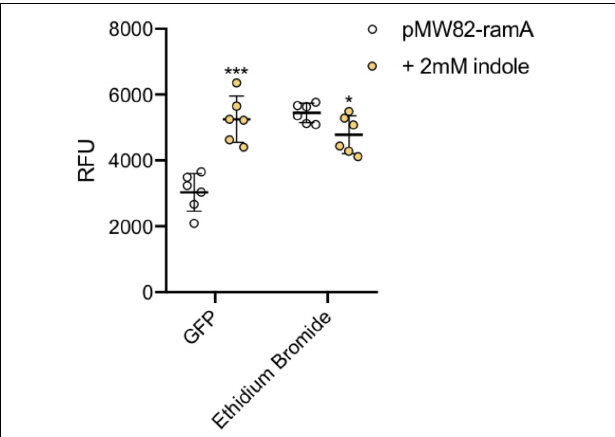
FIGURE 8 | Accumulation of ethidium bromide and fluorescence of GFP. The ethidium bromide and GFP fluorescence ( x -axis) were measured in SL1344 pMW82-ramA in the absence (white) and presence (orange) of 2 mM indole. 6 biological replicates for each strain are shown, with a long bar to show the mean and standard error of the mean (SEM) error bars. Ethidium bromide fluorescence of the strains is shown and is consistent with results above. The X-median RFU for GFP is shown without (white) and with (orange) the addition of indole in strains containing a pMW82- ramA transcriptional reporter. Without indole, the mean RFU is 2963 but with indole it is 5230 RFU. Unpaired T -tests were run to compare fluorescence of GFP and ethidium bromide with and without indole. The P -value for GFP ( ∗∗∗ ) was 0.0001; The P -value for EtBr ( ∗ ) was 0.0315.